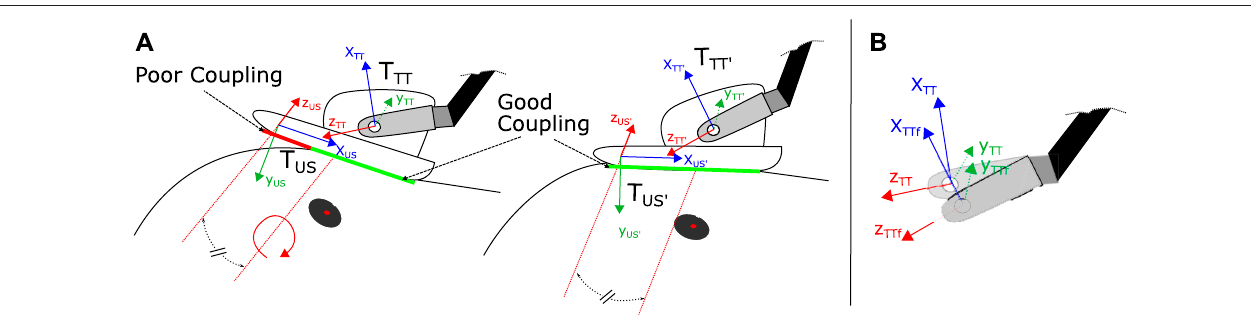
FIGURE 2 | (A) Coupling adaption of the US probe via rotation around z US axis (equivalent to image normal vector), shifted into the center of the image probe. To determine the amount and direction of probe angle adaption we use the condensed c COM parameter (see Eq. 3 ) (B) Update of the end-effector orientation and global position T TT via attitude sensor fusion resulting in fused tool tip frame T TTf . Based on T TTf , T US is updated as well (not depicted for